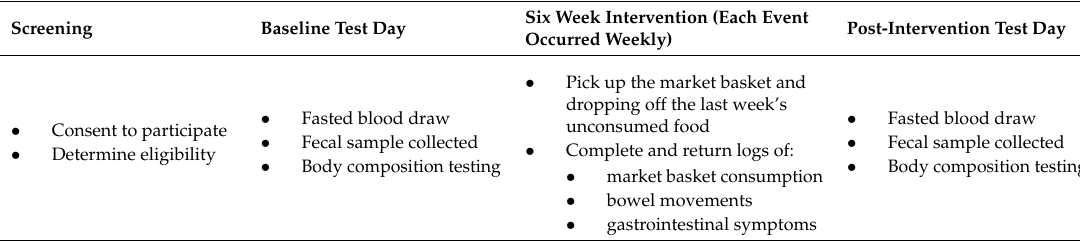
Table 1. Study design and